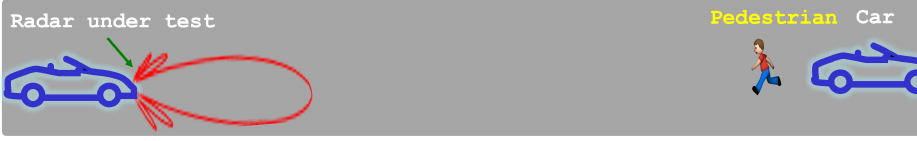
Figure 6. A representative scenario designed for